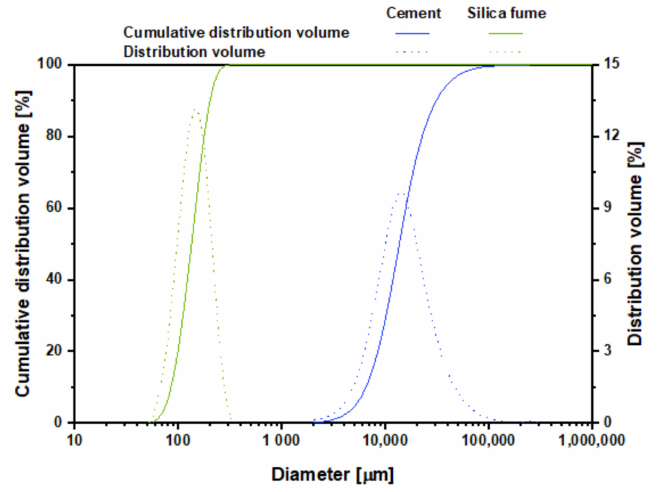
Figure 2. Particle-size distributions of the binder